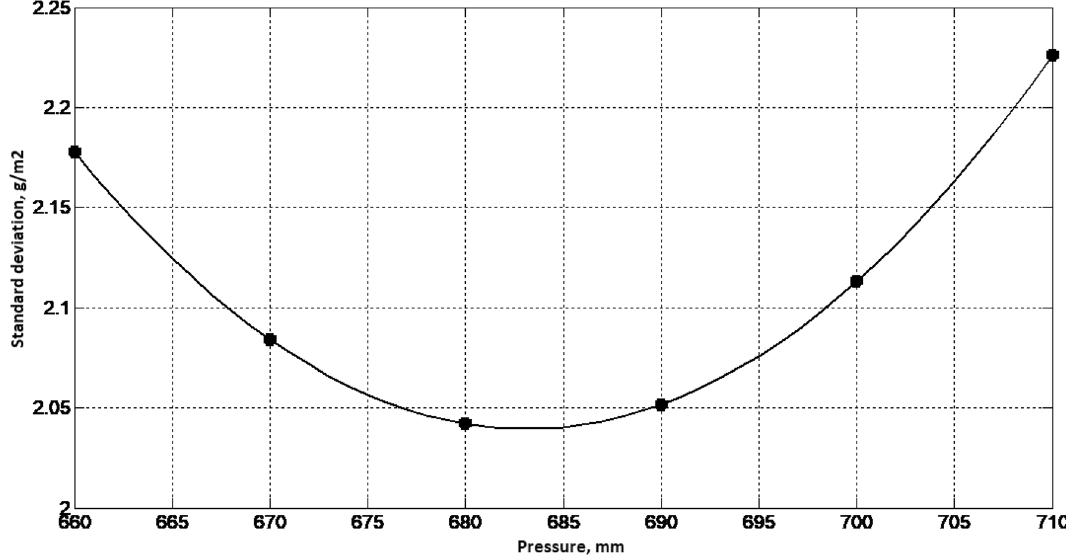
Fig. 1 Extreme dependence of the standard deviation on the pressure of the paper